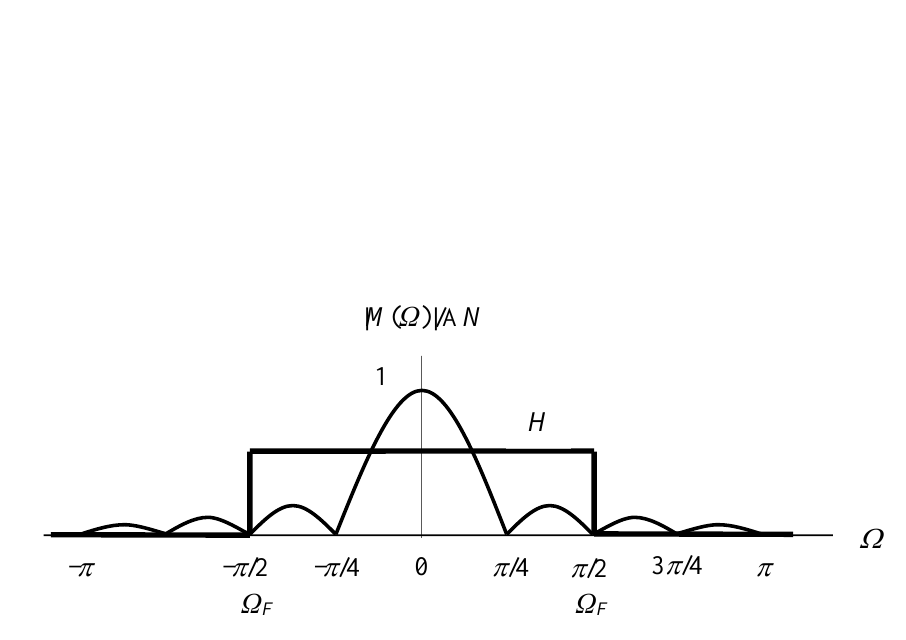
Figure 15 − Spectra of the rectangular pulse and the impulse response of the LP filter Рис. 15 – Спектры прямоугольного импульса и импульсная характеристика